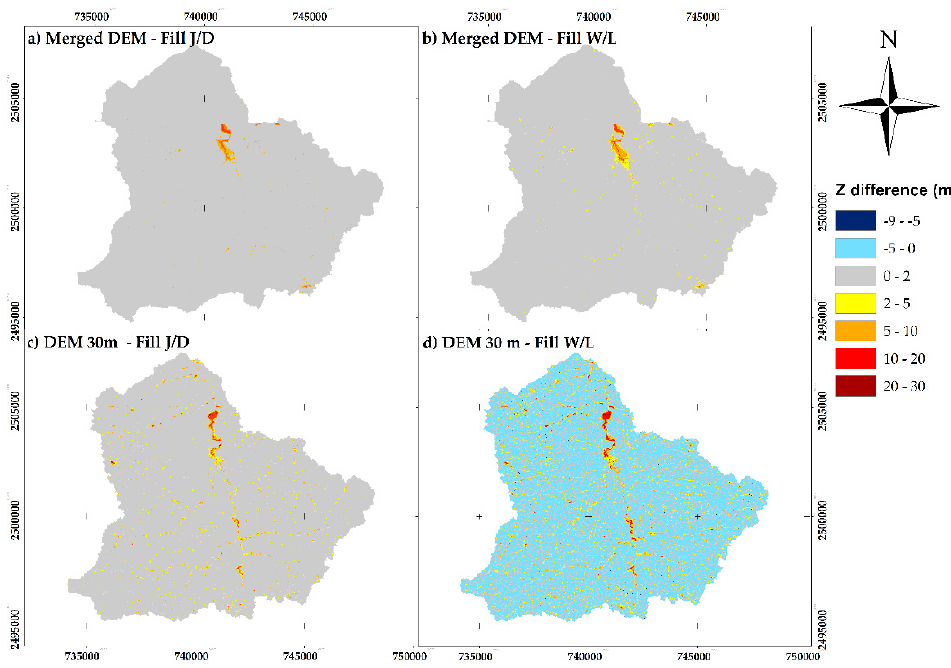
Figure 3. Difference of cell elevation in pre-treated DEMs against fill DEMs: ( a ) merged DEM–fill DEM J/D, ( b ) merged DEM–fill DEM W/L, ( c ) DEM 30 m–fill DEM J/D, and ( d ) DEM 30 m–fill DEM W/L.